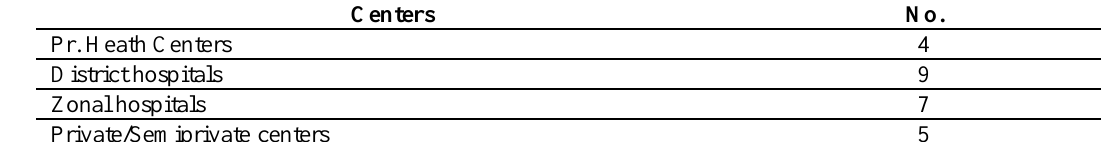
Table II : Referring centers (n = 25)